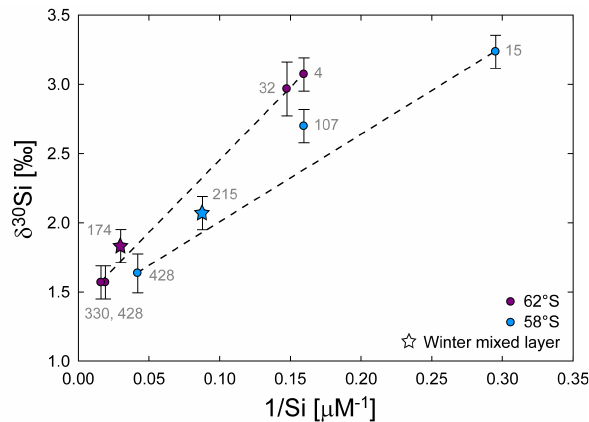
Fig. 6. A mixing diagram of δ 30 Si versus 1/[Si] for samples in the near-surface polar ocean. Stars represent the winter mixed layer (identified by the temperature minimum (62 ◦ S) or potential vor- ticity minimum (58 ◦ S)). Dotted lines are drawn between the shal- lowest and deepest samples (depths indicated by gray numbers, in meters) to guide the eye; note that the winter mixed layer at 58 ◦ S appears to be more consistent with mixing between the base of the mixed layer and the deeper water column, which highlights that the real system is more spatially complex than assumed in this simple